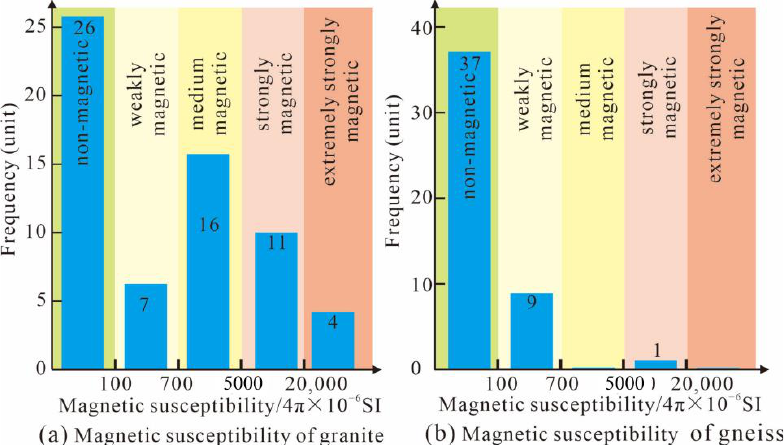
Figure 6. Magnetic susceptibility histograms of granite and gneiss in the ECSB and its adjacent areas. Note: ( a , b ) show magnetic susceptibility statistics for granite and gneiss samples, respectively.